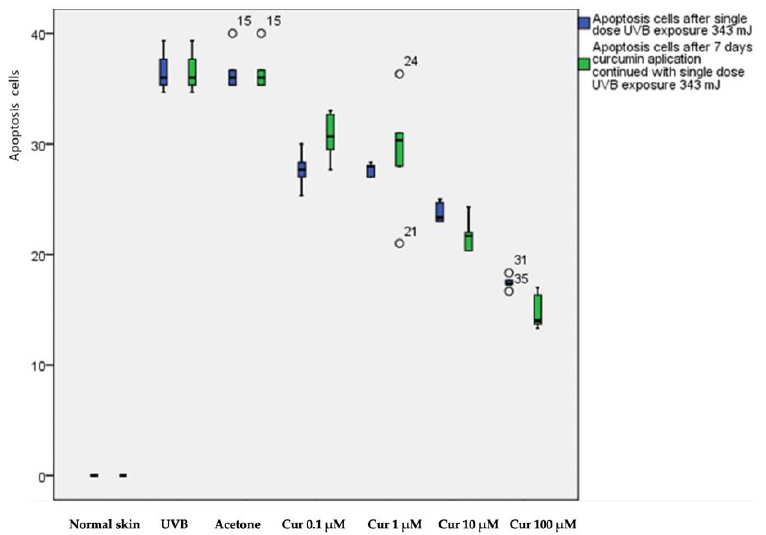
Figure 1. Induction of apoptosis in UVB-irradiated mice. Pretreatment with topical curcumin before UVB irradiation prevented apoptosis in both experimental models.